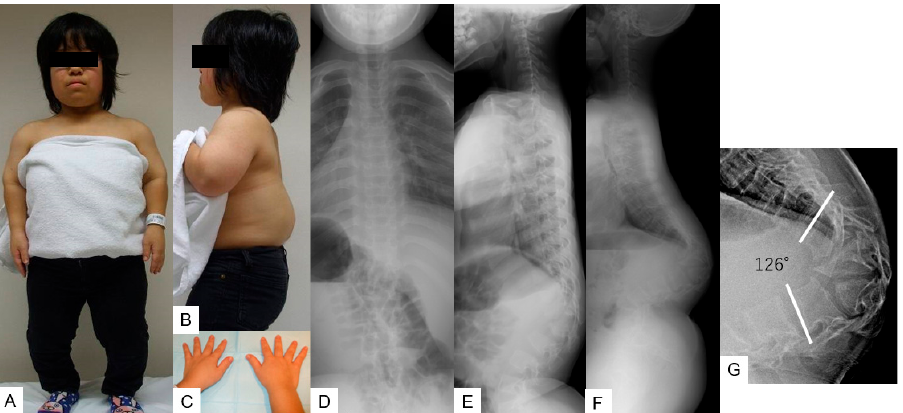
Figure 1. A 16-yearold girl with achondroplasia; preoperative figure and radiograms. ( A , B ) The patient’s posture shows dwarfism with short limbs and severe thoracolumbar kyphosis; ( C ) hands are three-pronged (trident) in appearance; ( D , E ) radiograms at initial visit; ( F , G ) lateral radiogram shows severe sagittal malalignment; T11-L2 local kyphosis 126°, SVA 55 mm, PT 32°, and PI 52°.